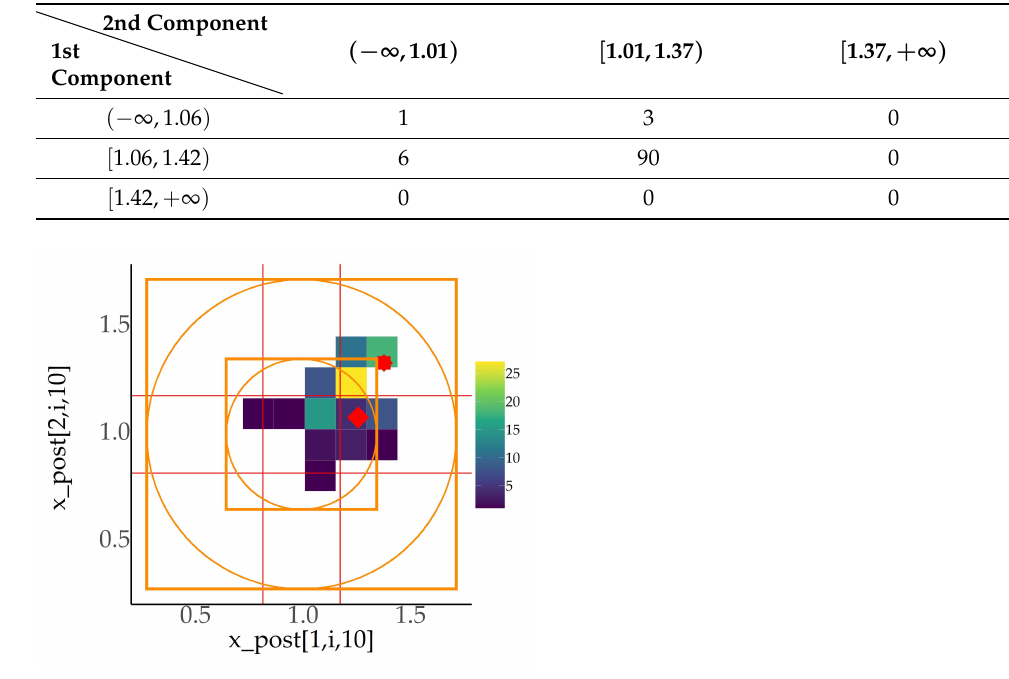
Table 6. Frequency table of the particle distribution over the grid around the mean of the sample in the end of t = 10.